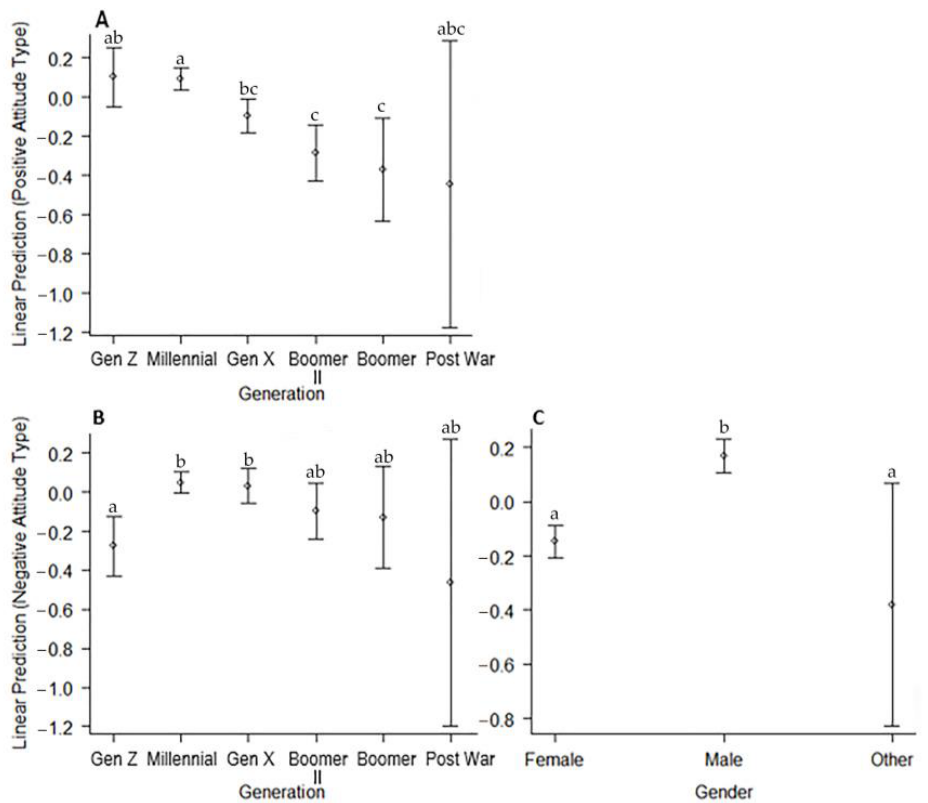
Figure 2. Predictor effect plots for regression models for the sloth experiment, showing the effect of ( A ) generation on positive attitudes and ( B ) generation and ( C ) gender on negative attitudes. In each panel, results are averaged over levels of other predictor variables. Linear predictions are shown with 95% confidence intervals as error bars. Predictor levels that do not share any letter are significantly different ( p < 0.05) as determined by pairwise comparisons conducted using the Tukey method.